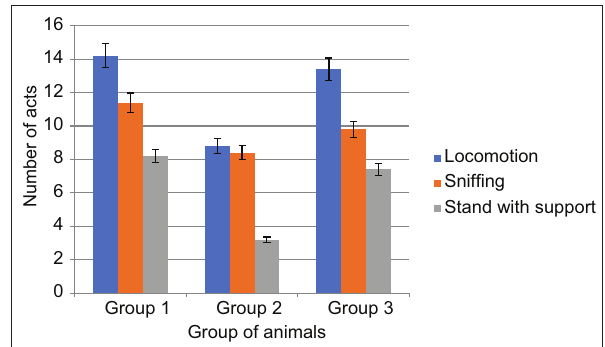
Figure-1: Changes in the number of acts of locomotion, sniffing, and stand with the support of animals when exposed from the Samsung Galaxy J1 Mini and Xiaomi Redmi S2 phones.